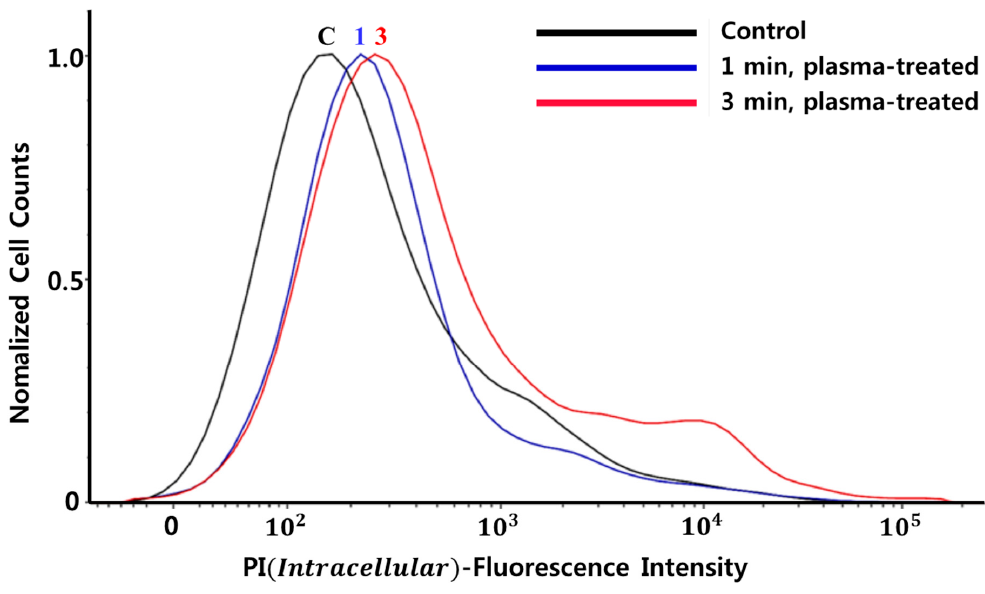
Figure 6. Fluorescence intensity of PI-stained C . pruinosa spores treated by the soft plasma jet. C, 1, and 3 represent the fluorescence intensity of PI-stained C . pruinosa spores for the control, 1 min, and 3 min plasma-treated spores, respectively. Cell wall integrity was investigated by measuring the fluorescence intensity of C . pruinosa spores stained with a membrane-impermeable fluorophore, PI. Figure 7 exhibits the CD spectra of the C . pruinosa spores treated by the soft plasma jet. The control CD spectrum of the plasma non-treated spores exhibited a negative dip at about 230 nm and 285 nm.